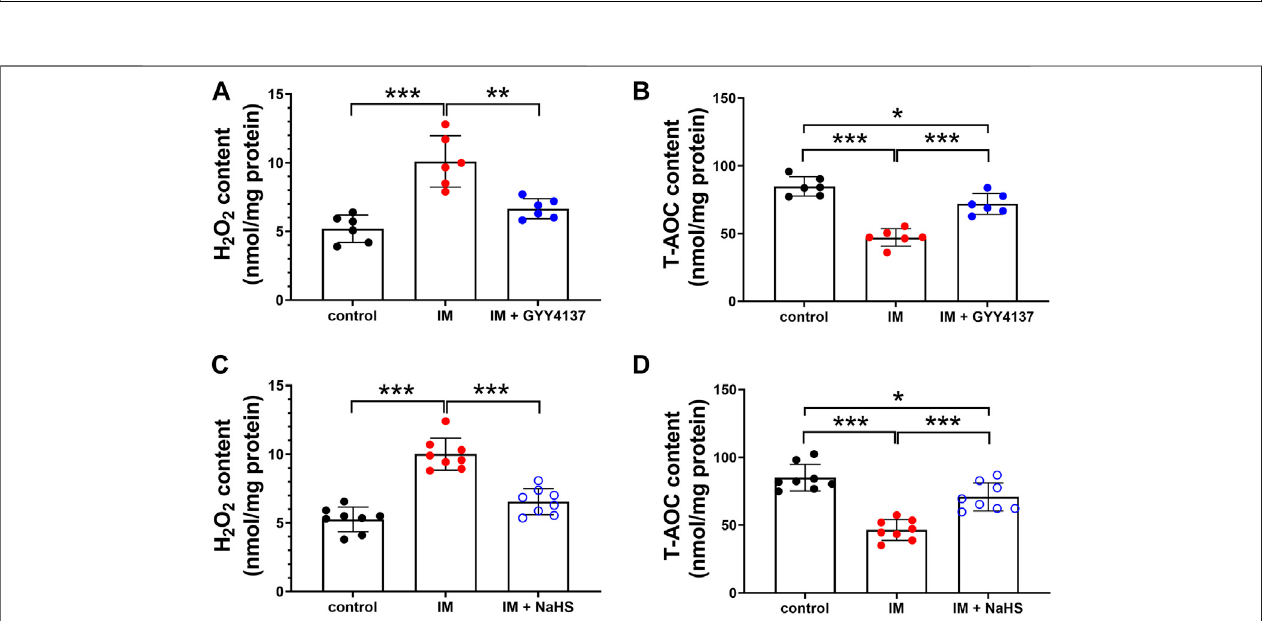
FIGURE 7 | H2S donors repress the IM-induced oxidative stress in skeletal muscles. Mice were subjected to IM and treated with GYY4137 (a and b, 50 μ g/kg/d, ip), or NaHS (c and d, 1.12 mg/kg, twice a day, ip) for 2 weeks. The control and IM groups received identical doses of saline for 2 weeks. (A) , The level of H 2 O 2 in GAS muscle homogenates in control, IM, and IM + GYY4137 mice (n = 6 in each group). (B) , The level of T-AOC in GAS muscle homogenates in control, IM, and IM + GYY4137 mice (n= 6in each group). (C) , The level ofH 2 O 2 in GASmuscle homogenatesin control, IM, and IM+ NaHS mice (n =8 ineach group). (D) ,The level of T-AOC in GAS muscle homogenates in control, IM, and IM + NaHS mice (n = 8 in each group). Data represent means ± SEM. * p < 0.05, ** p < 0.01, *** p < 0.001.